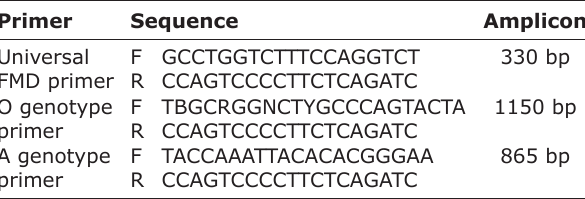
Table-1: The primers of the cDNA of the FMDV.